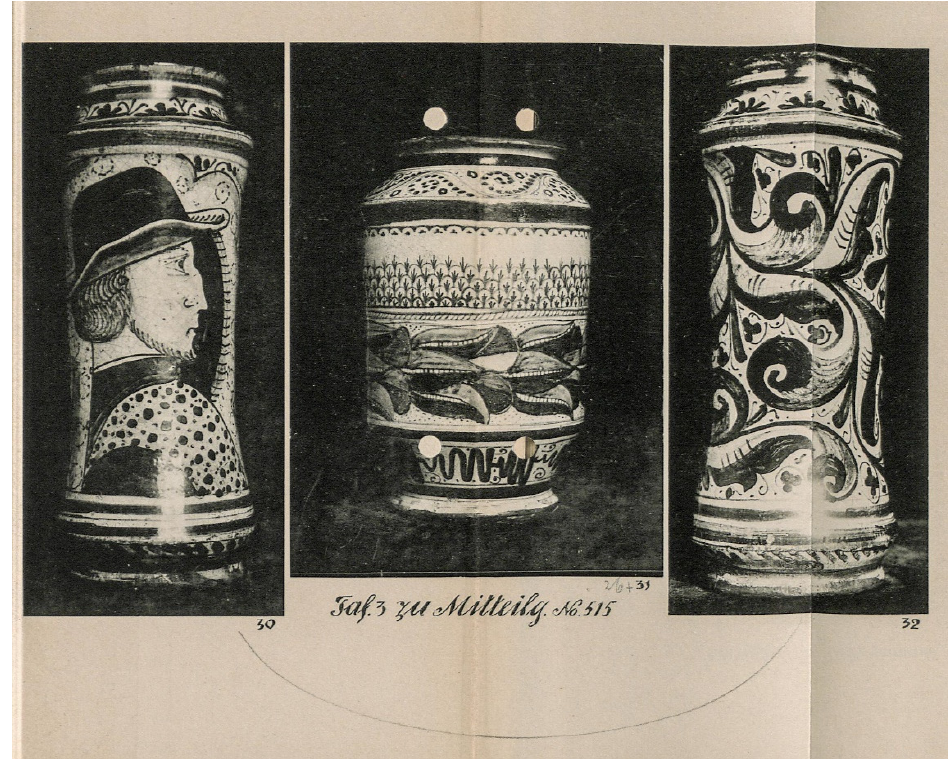
Figure 2. Detail of a larger series of more than 20 maiolica provided as plates in the Mitteilungen by Otto von Falke in 1925, when he returned to the topic that he had treated before the war. Scan by Kunstbibliothek Berlin, used by permission.